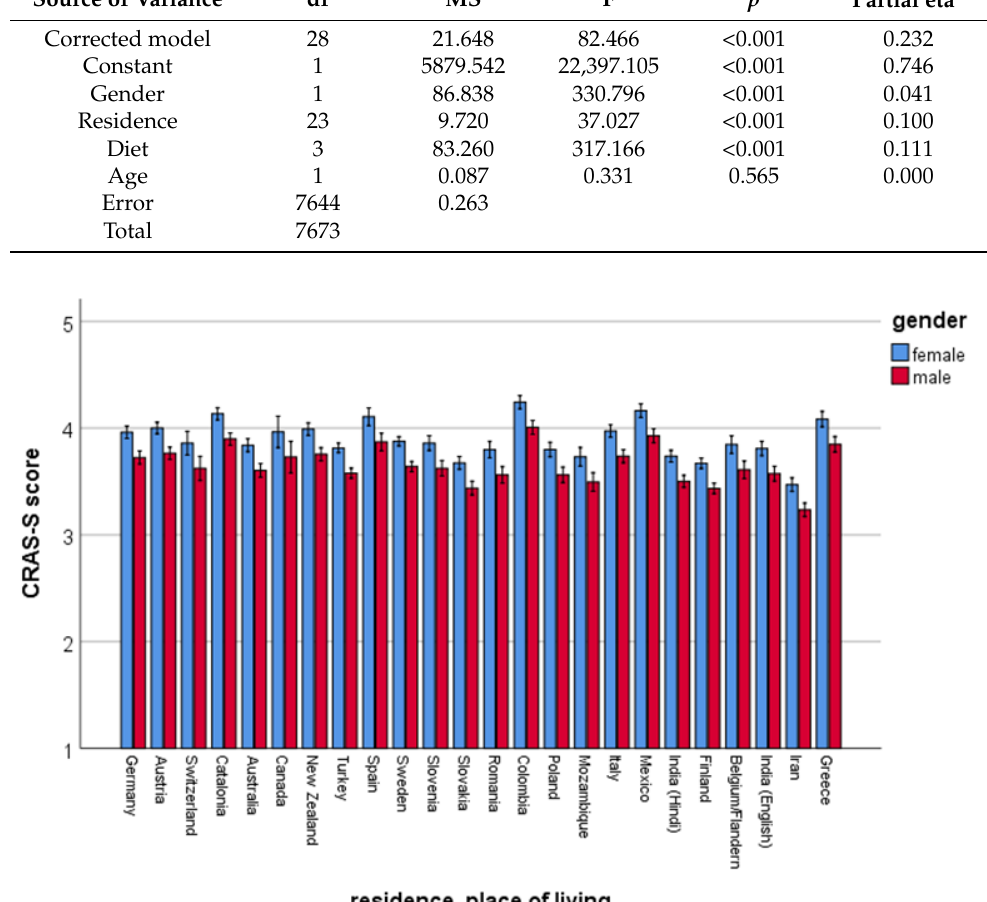
Figure 1. Gender differences according to countries (based on the estimated marginal means derived from the general linear model). Higher scores represent higher pro-animal welfare attitudes. Animal welfare attitudes (AWA) were measured with the Composite Respect for Animals Scale-Short Version (CRAS-S).